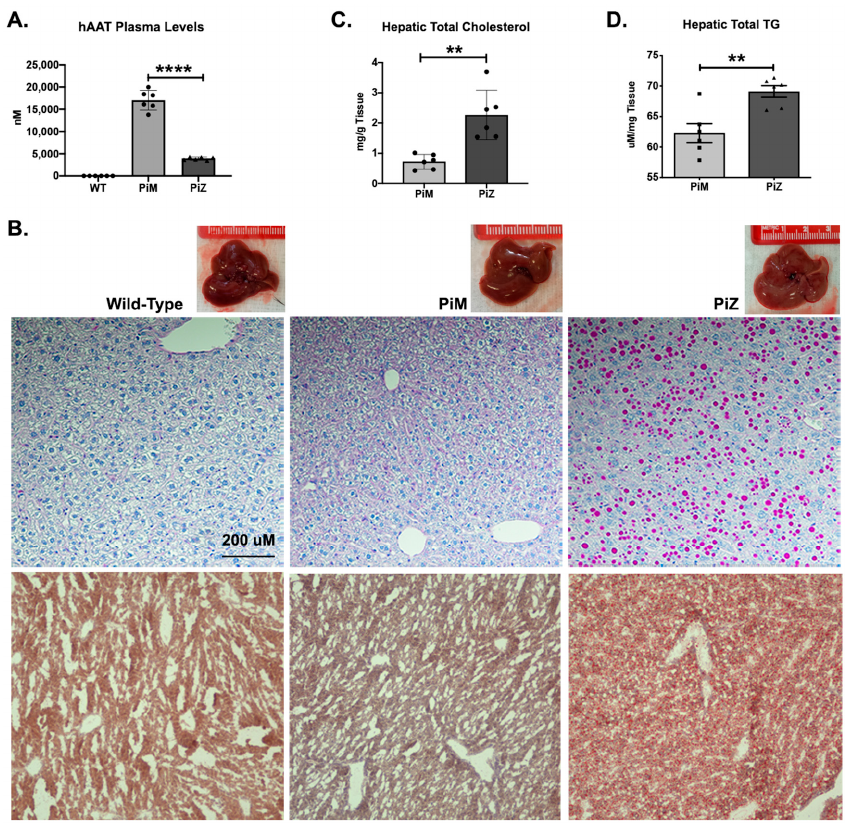
Figure 1. Characterization of Pi*M and PI*Z transgenic mice. ( A ) Enzyme-linked immunosorbent assay (ELISA) was used to measure human alpha-1 antitrypsin (hAAT) from the plasma of wild-type, Pi*M, and Pi*Z transgenic mice ( n = 6); ( B ) PAS-D staining using immunohistochemistry on liver tissue of wild-type, Pi*M, and Pi*Z mice (top row). Neutral lipids and lipid droplets were assessed in Pi*Z transgenic mice and compared to Pi*M and wild type using H&E and Oil Red O staining, respectively (middle and bottom rows). ( C ) Hepatic total cholesterol and ( D ) triglycerides (TG) quantified by colorimetric assay from the Pi*M and Pi*Z mice liver tissue. ** p < 0.001, **** p < 0.0001.